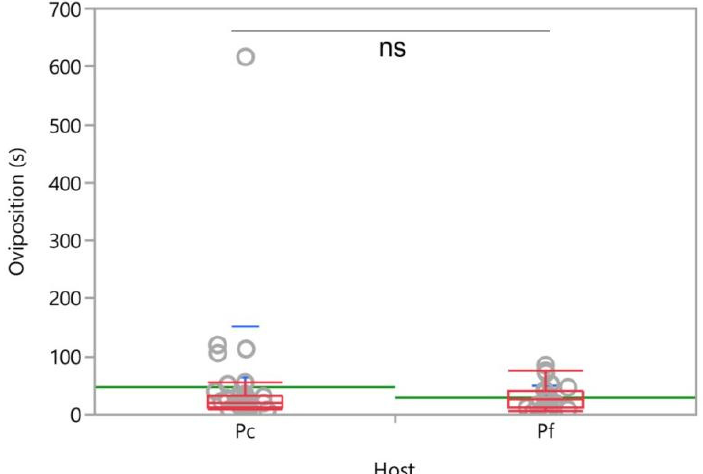
Figure 10. Oviposition duration of Anagyrus vladimiri in two-choice 20-min tests evaluating host preferences for Pseudococcus comstocki (Pc) vs. Planococcus ficus (Pf). Each box plot indicates the median (central line) and its range of dispersion (lower and upper quartiles an and outliers); green lines indicate the means, while light blue T-bars indicate standard errors; ns = not significant, it indicates the lack of significant differences (Kruskal–Wallis test, p > 0.05).